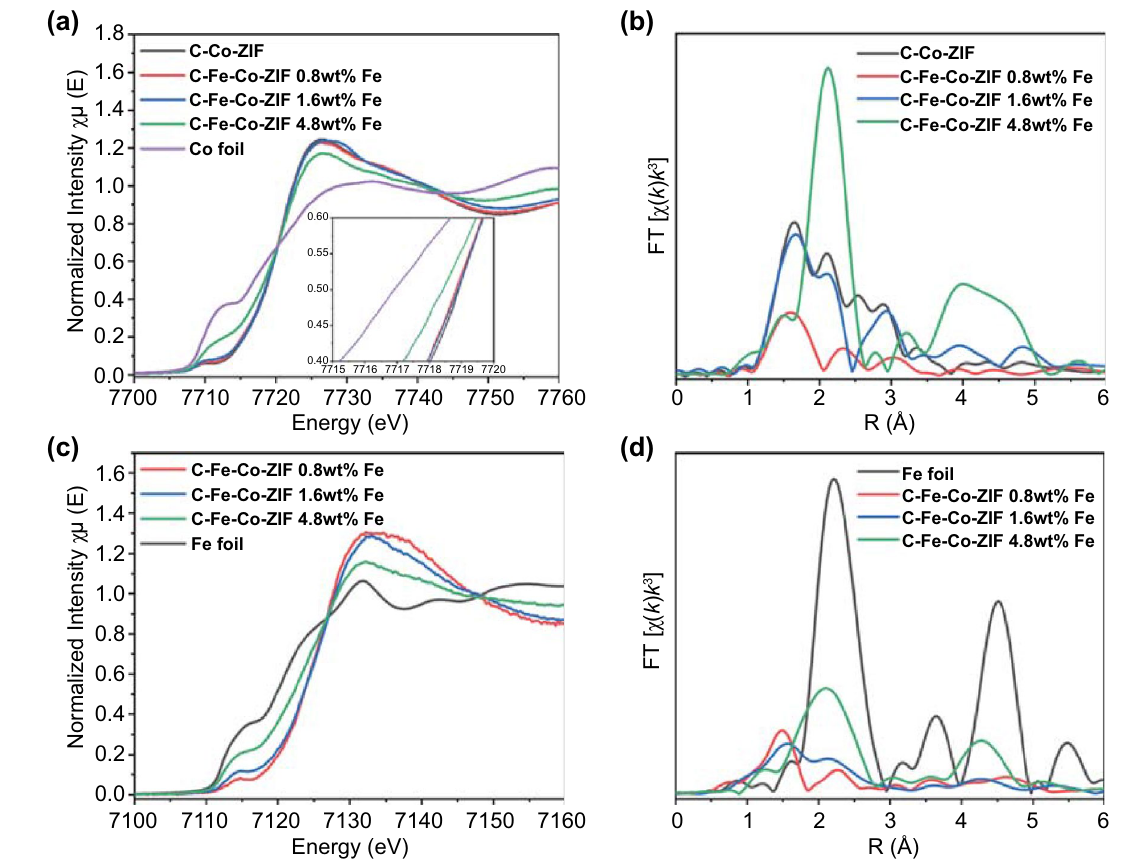
Fig. 5 a Co K-edge XANES, inset: enlarged region of the white line. b Co EXAFS. c Fe K-edge XANES. d Fe EXAFS of C–Fe–Co–ZIF sam-